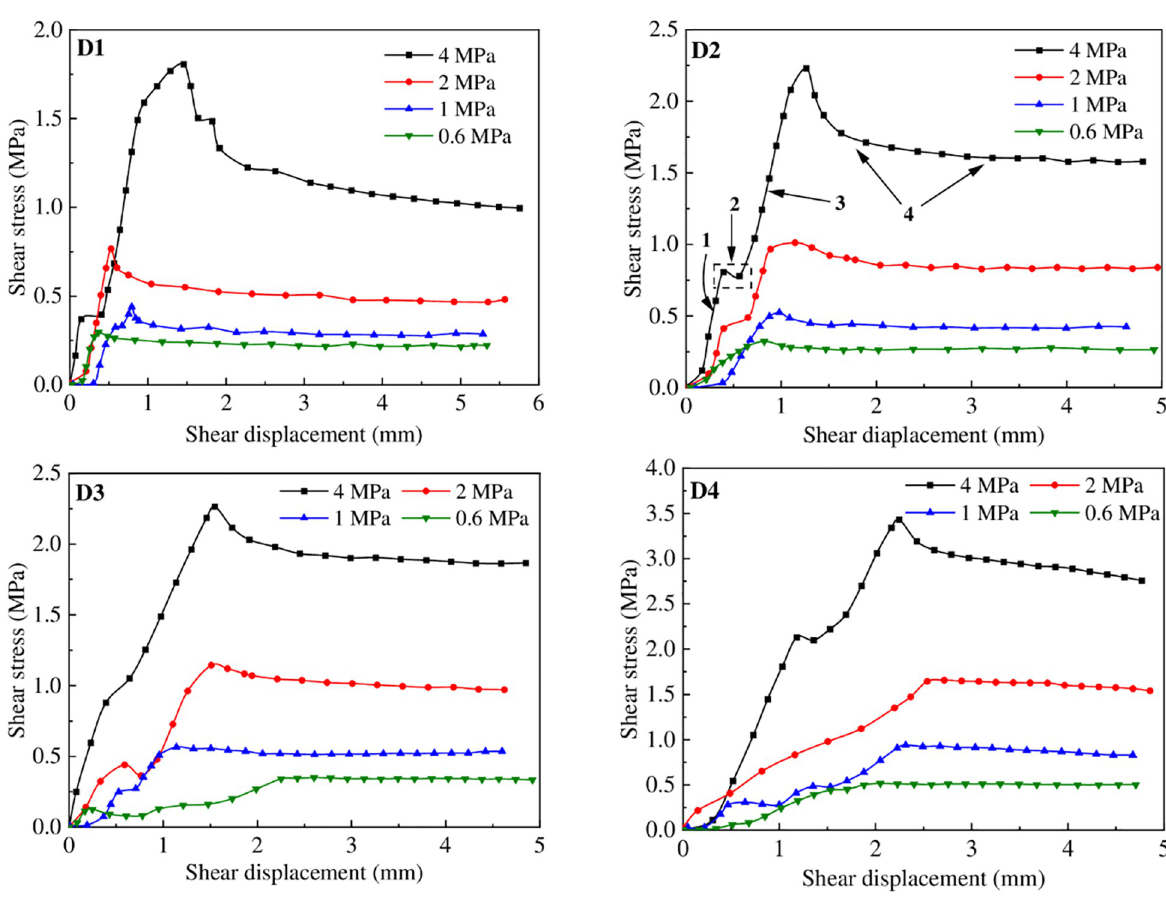
Fig 8. Shear stress versus shear displacement plots: (a) D1; (b) D2; (c) D3; and (d)